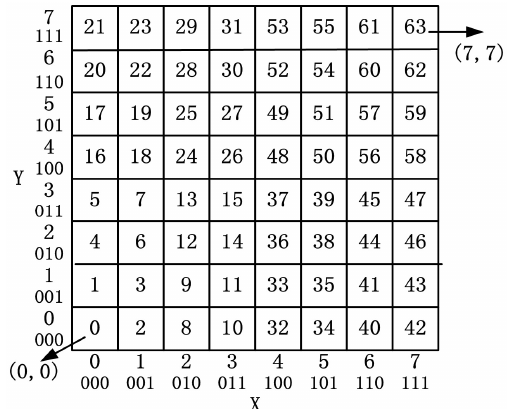
Figure 2. The M code of the expanding monitoring area.